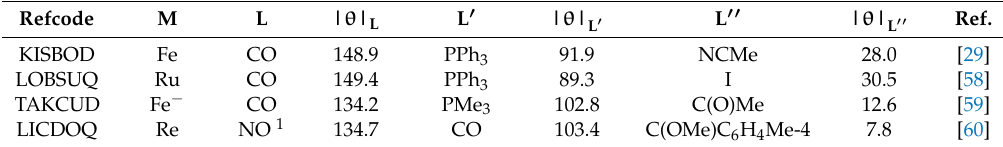
Table 6. ELO data ( θ , / ◦ ) in [3-L-3-L (cid:48) -3-L (cid:48)(cid:48) - closo -3,1,2-MC 2 B 9 H 11 ] species.